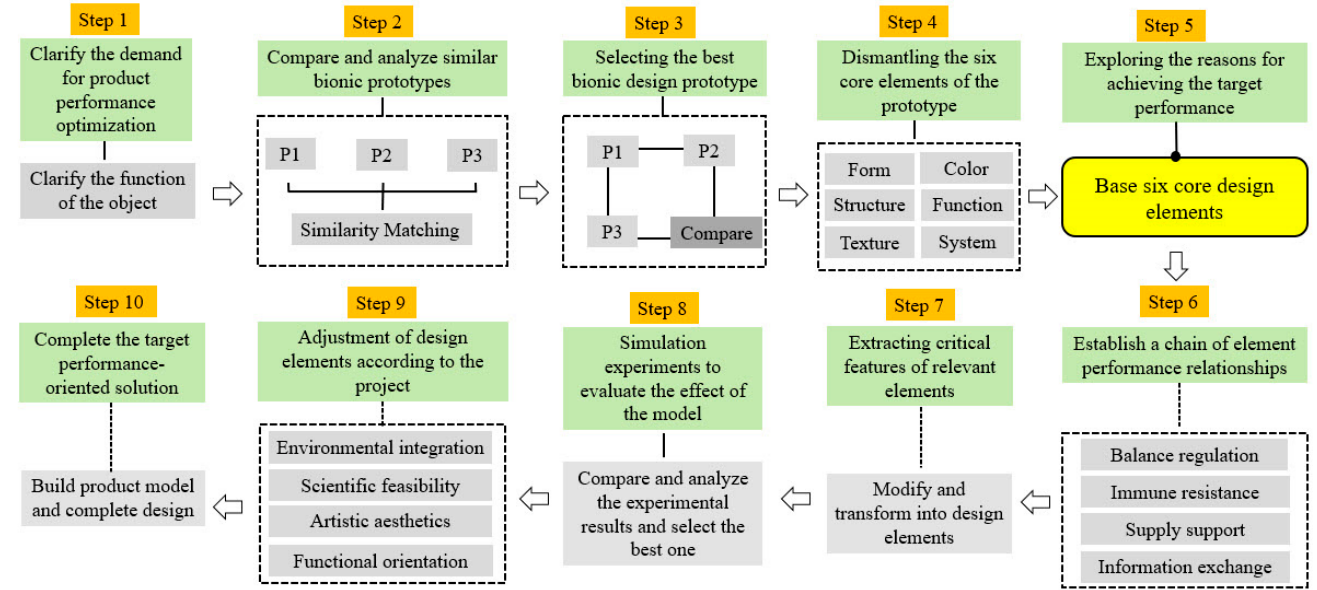
Figure 7. Six Elements and Ten Steps system bionic design method.